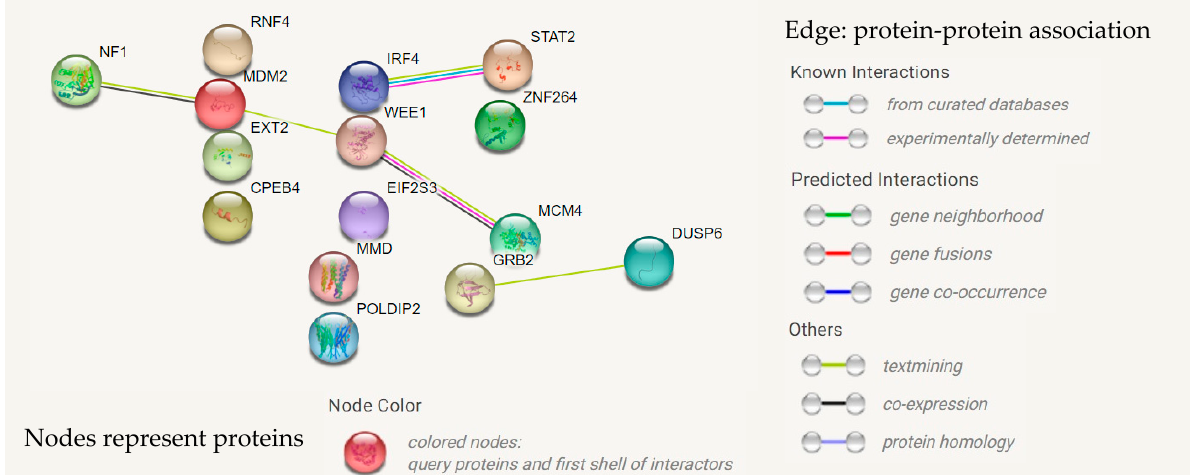
Figure 6. Schematic presentation of interactions between seven genes according to logistic analysis data (Table 5). The extent of change in percent of significance (PS) is indicated next to the notation for the interaction effect. Ground-PS, PS obtained from single-gene model (Table 3).